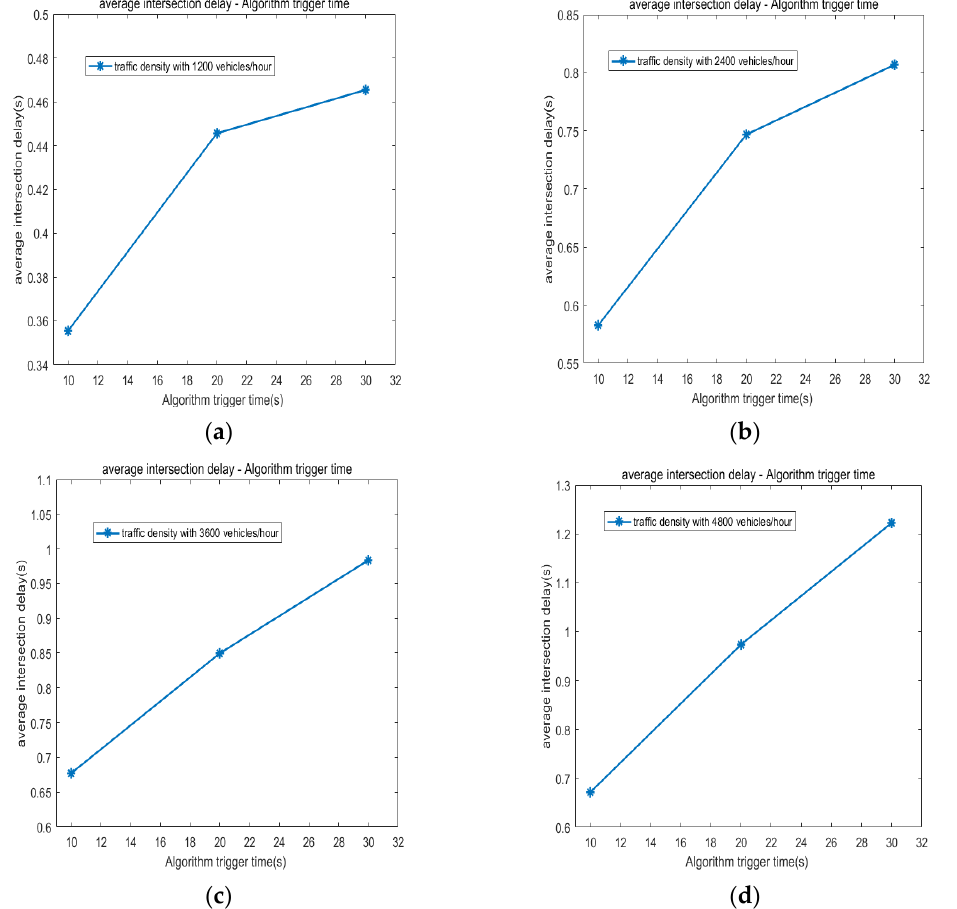
Figure 12. The relation between the parameter T and the average intersection delay with different traffic densities: ( a ) f 1 = 1200 veh/h, ( b ) f 2 = 2400 veh/h, ( c ) f 3 = 2400 veh/h, ( d ) f 4 = 4800 h .